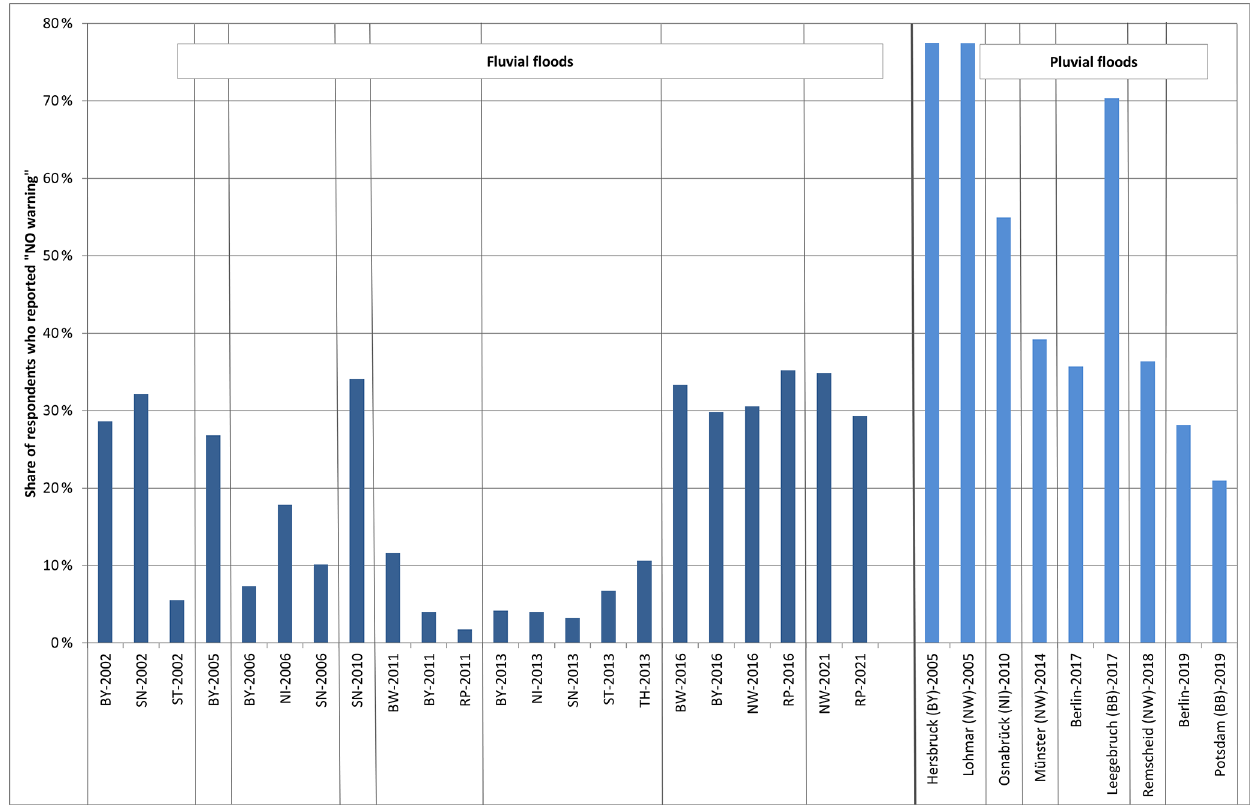
Figure 2. Share of respondents who reported that they had not been warned before the flood danger became imminent. Data are shown per flood event (year), federal state and flood type; left: fluvial floods from 2002 to 2021; right: some pluvial floods between 2005 and 2019 (abbreviations of the federal states – BB: Brandenburg; BW: Baden-Württemberg; BY: Bavaria; NI: Lower Saxony; NW: North Rhine- Westphalia; RP: Rhineland-Palatinate; SN: Saxony; ST: Saxony-Anhalt; TH: Thuringia; see Fig. 1 for geographic locations; see Table 1 for brief event descriptions). Table 3. Results of a logistic regression explaining the receipt of an official warning ( n = 1115; SE: standard error; _cons: constant). All variable definitions, coding and summary statistics are provided in the Supplement, Table